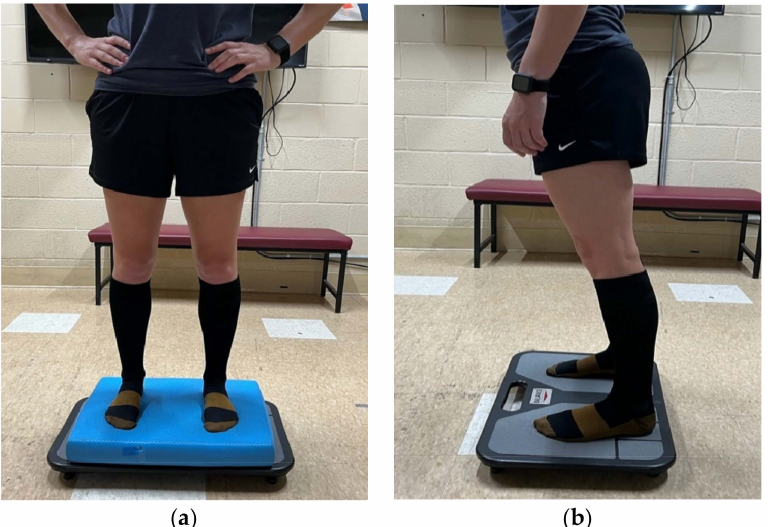
Figure 1. An example of a participant ( a ) performing the foam conditions (unstable surface) on the modified clinical test of sensory integration on balance (mCTSIB) and ( b ) performing the limits of stability (LOS) test on a hard firm surface wearing compression